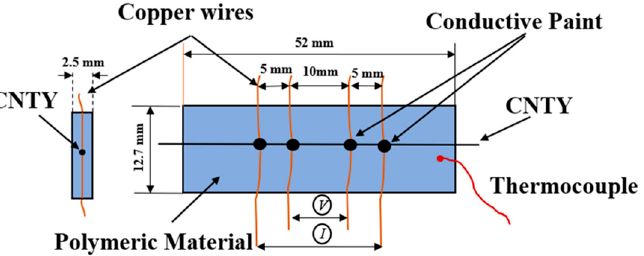
Figure 2. Schematic and dimensions of CNTY/silicone monofilament composite specimens.